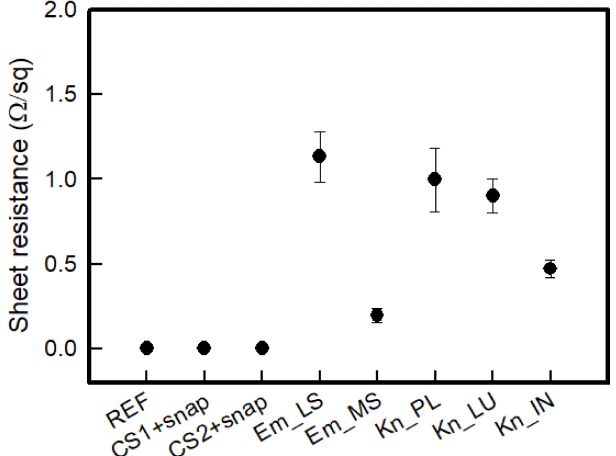
Figure 4. Sheet resistance of textile-based dry electrodes with various types.